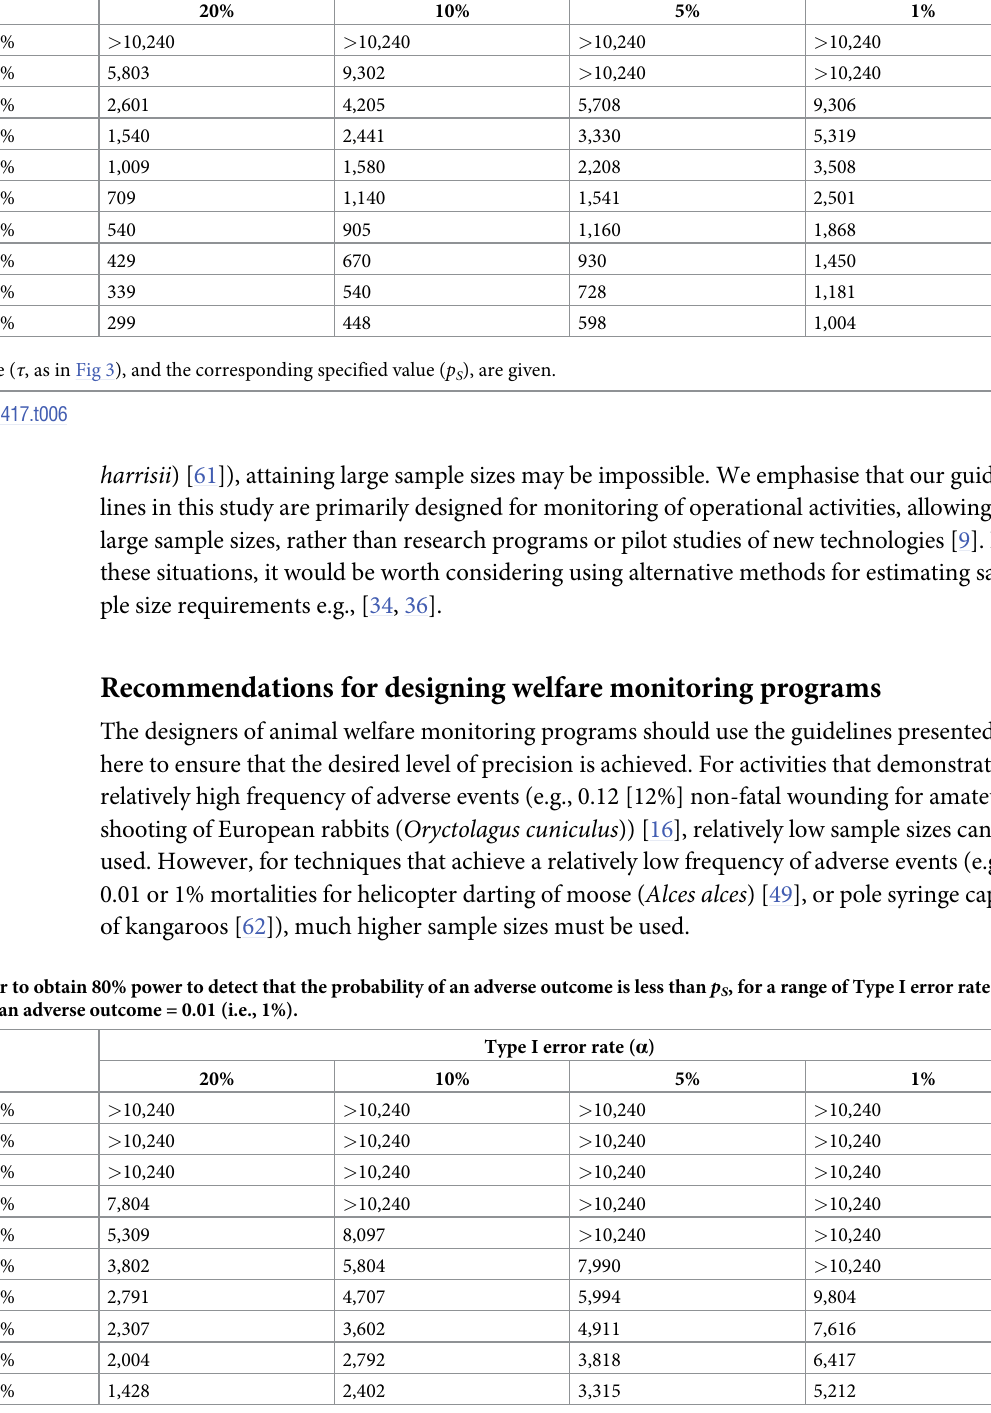
, for a range of Type I error rates ( α ), S